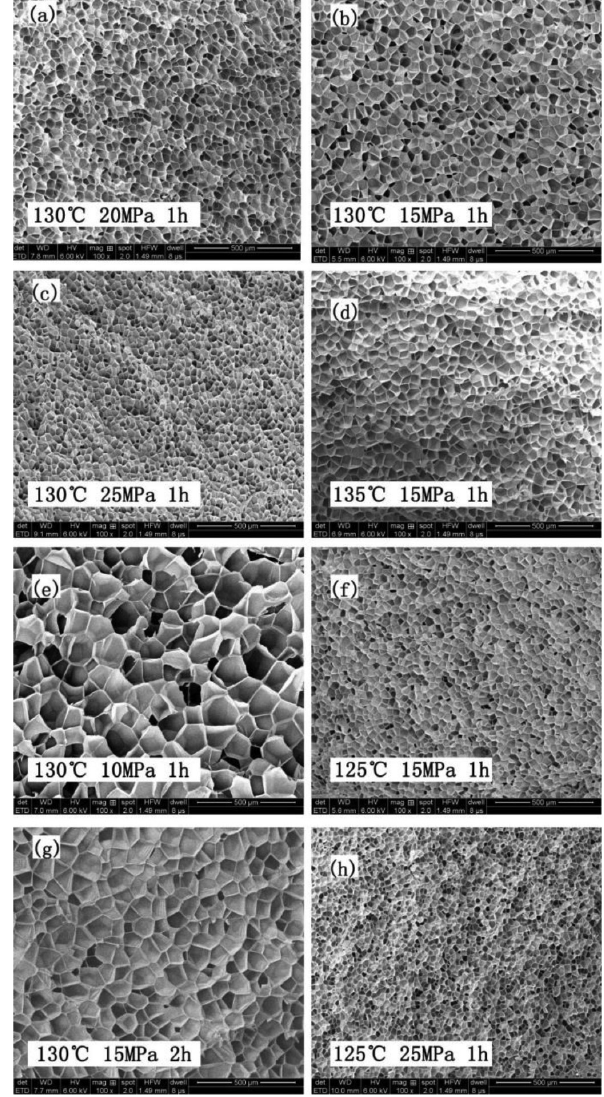
Figure 3: SEM images of PS-MCF samples: (a) 130°C, 20 MPa, 1 h;